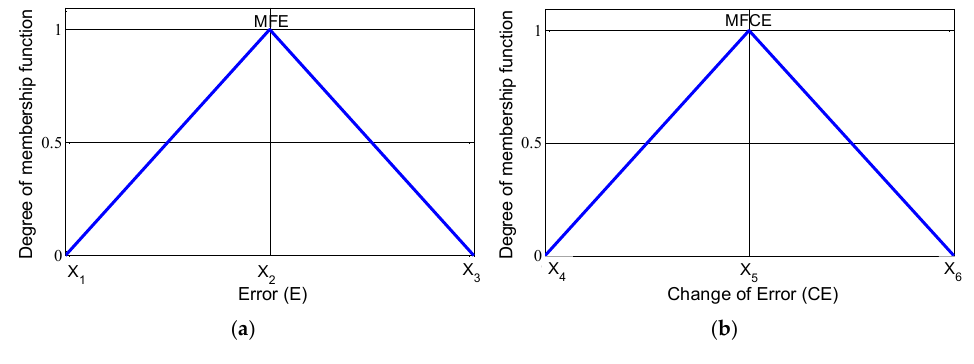
Figure 3. Membership functions for ( a ) E and ( b ) CE.